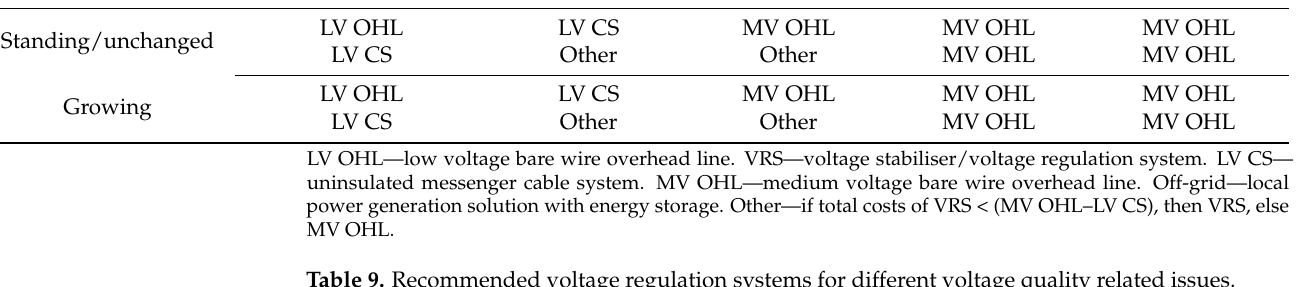
Table 9. Recommended voltage regulation systems for different voltage quality related